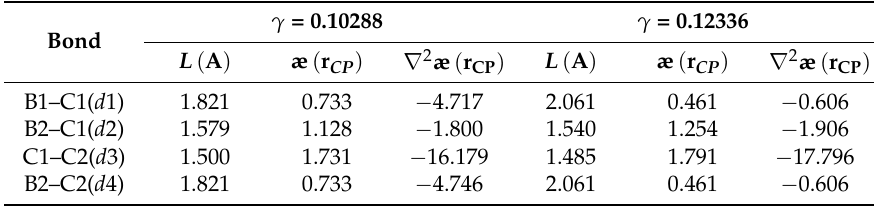
Table 2. Bond critical point data of t- BC 2 structure before and after shear instability. L is the bond length. ρ p r CP q and ∇ 2 ρ p r CP q are the charge density and its Laplacian at the corresponding critical